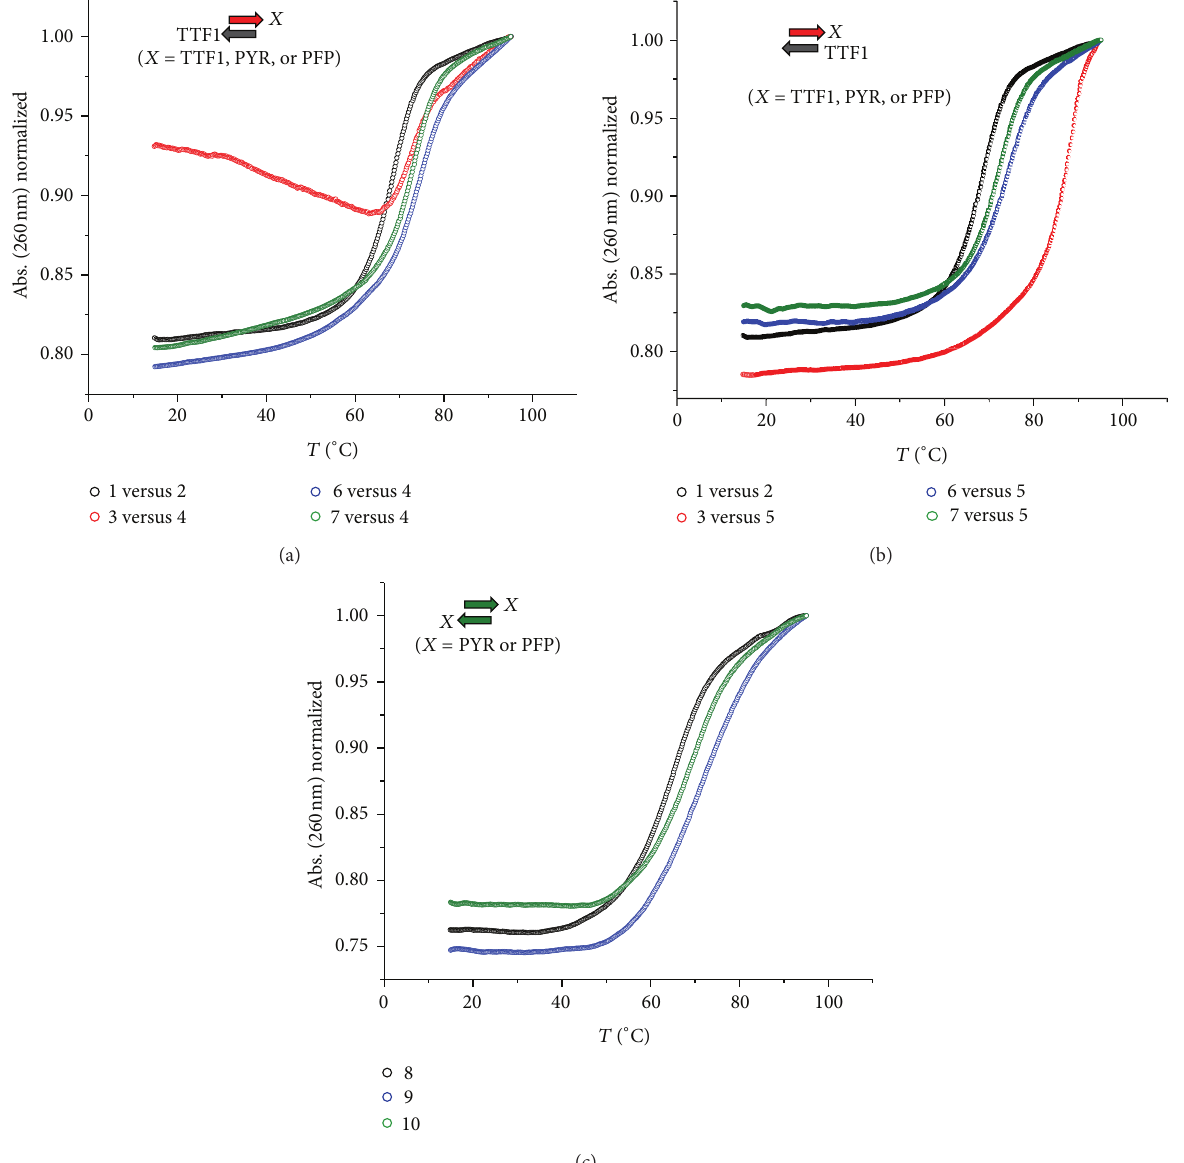
Figure 1: Melting curves of unmodified 15mer duplex 1 + 2 and duplexes carrying aromatic groups (a) at opposite sites and (b) at the same duplex site. (c) Melting curves of unmodified self-complementary duplex 8 and duplexes carrying two pyrene ( 9 ) or two pentafluorophenyl ( 10 ) units at opposite sites. Buffer: 1M NaCl, 10mM sodium phosphate buffer, pH =